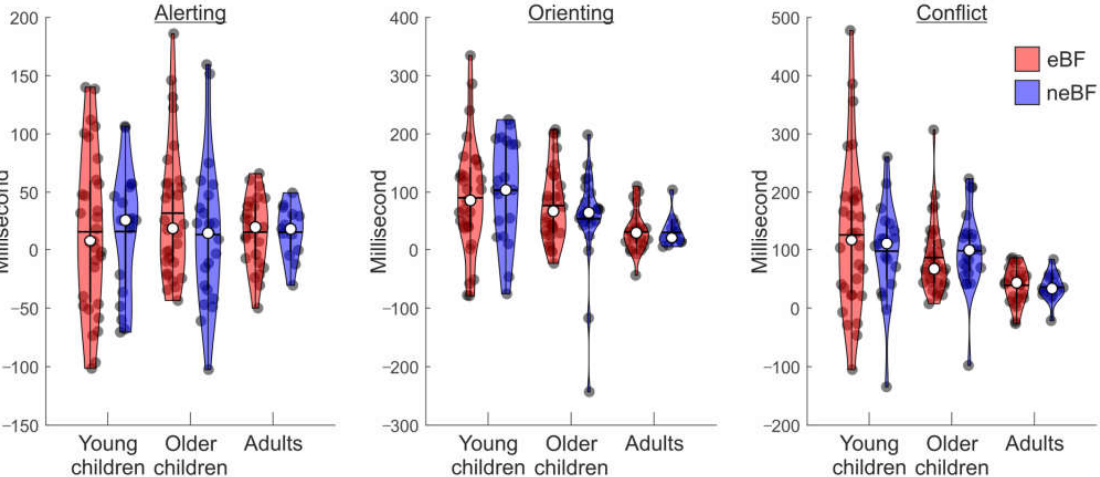
Figure 2. Violin graphs displaying the participants’ performance related to the three components of the ANT, namely alerting, orienting, and conflict, as a function of the age groups, and pattern of nutrition during 0–6 months of life. For each violin, the dark circles represent the individual performance; the median and mean of the distribution are represented by the white circle and the horizontal bar, respectively.